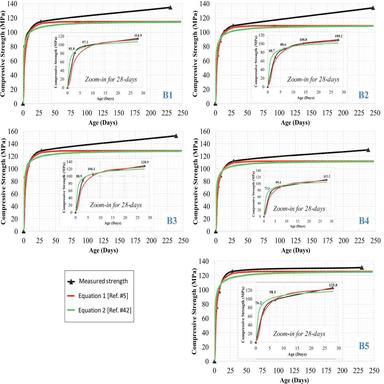
Compressive strength gain of NP-UHPC mixes in comparison with prediction equations.